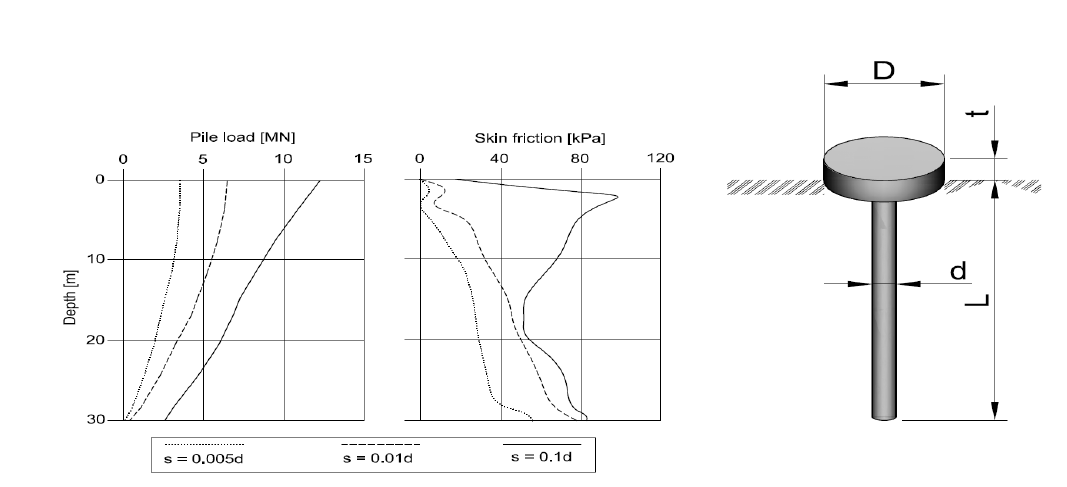
Figure 2. Influence of the pile-raft interaction on axial load transfer and skin friction with depth based on the Frankfurt Clay model (Katzenbach et al.